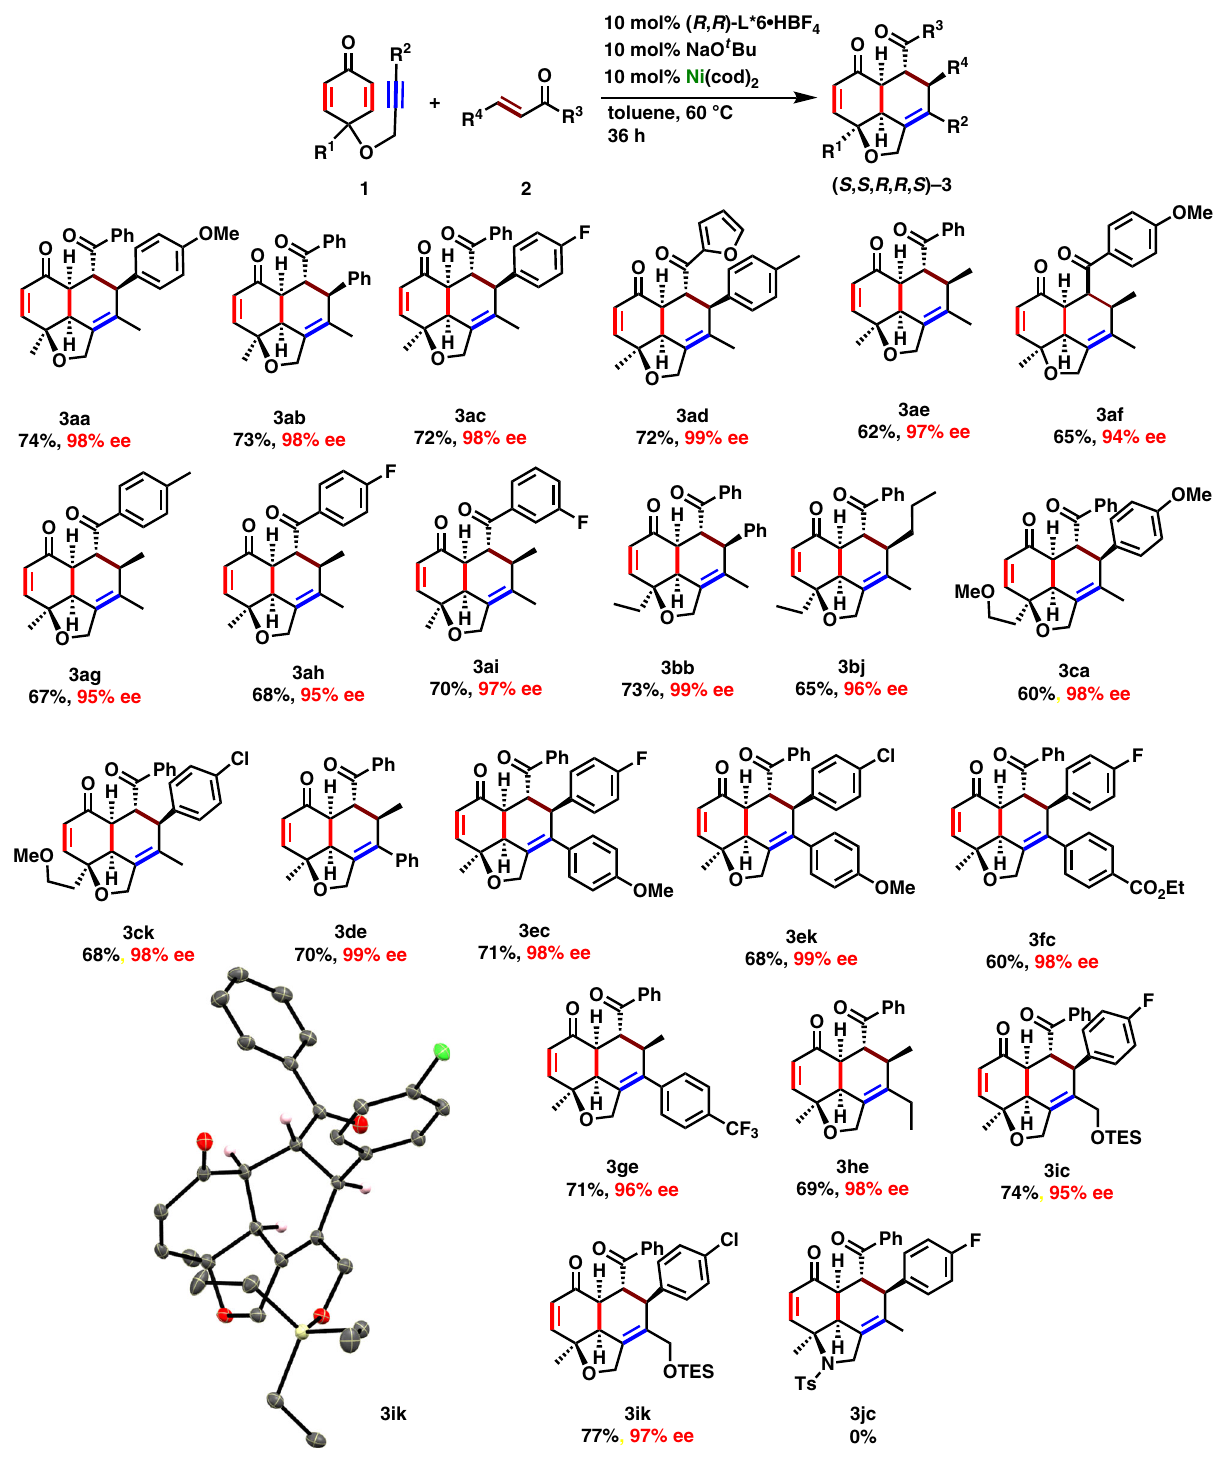
Fig. 3 Substrate Scope. Reaction was examined at 0.1 − 0.4 mmol scale. Isolated yields are given and enantioselectivity was determined by SFC equipped with a chiral stationary phase. ORTEP diagram of 3ik is shown with thermal ellipsoid at 30% probability level. Hydrogen atoms are omitted for clarity except those bound to the chiral carbon centers. Flack parameter for 3ik =